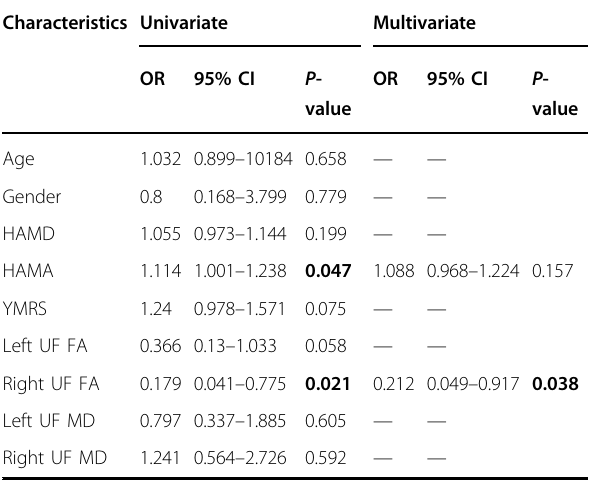
Table 2 Baseline characteristics related to subsequent onset of BD.